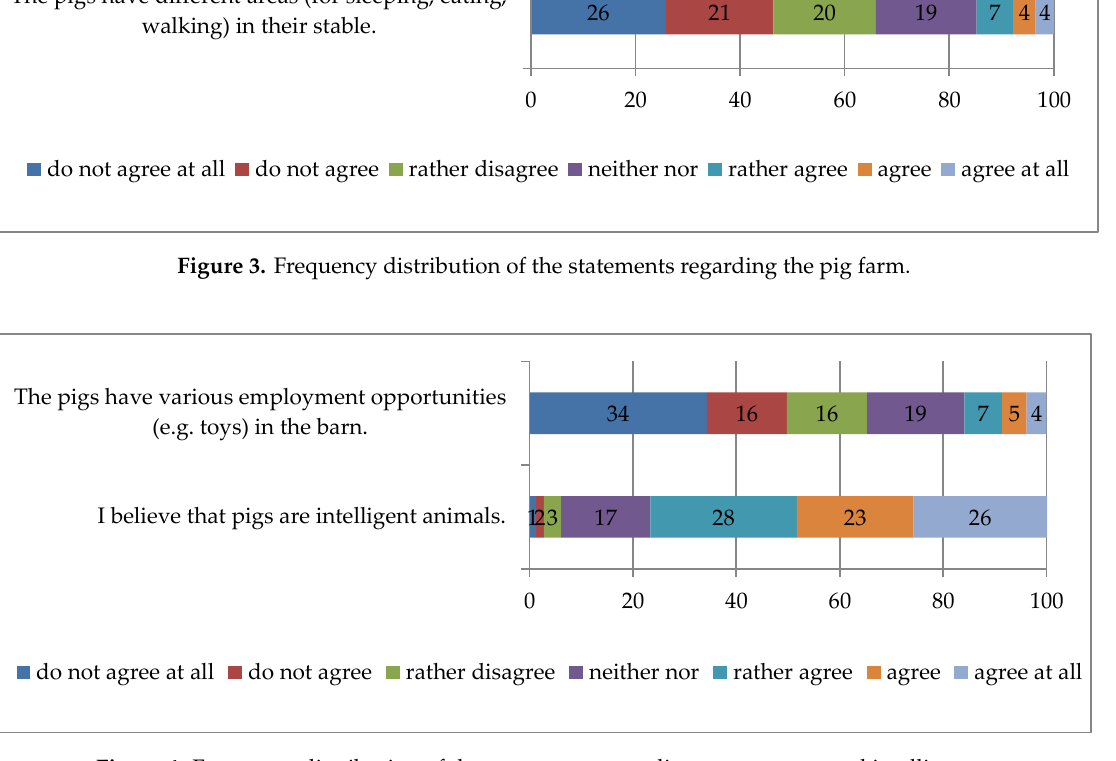
Figure 4. Frequency distribution of the statements regarding engagement and intelligence.